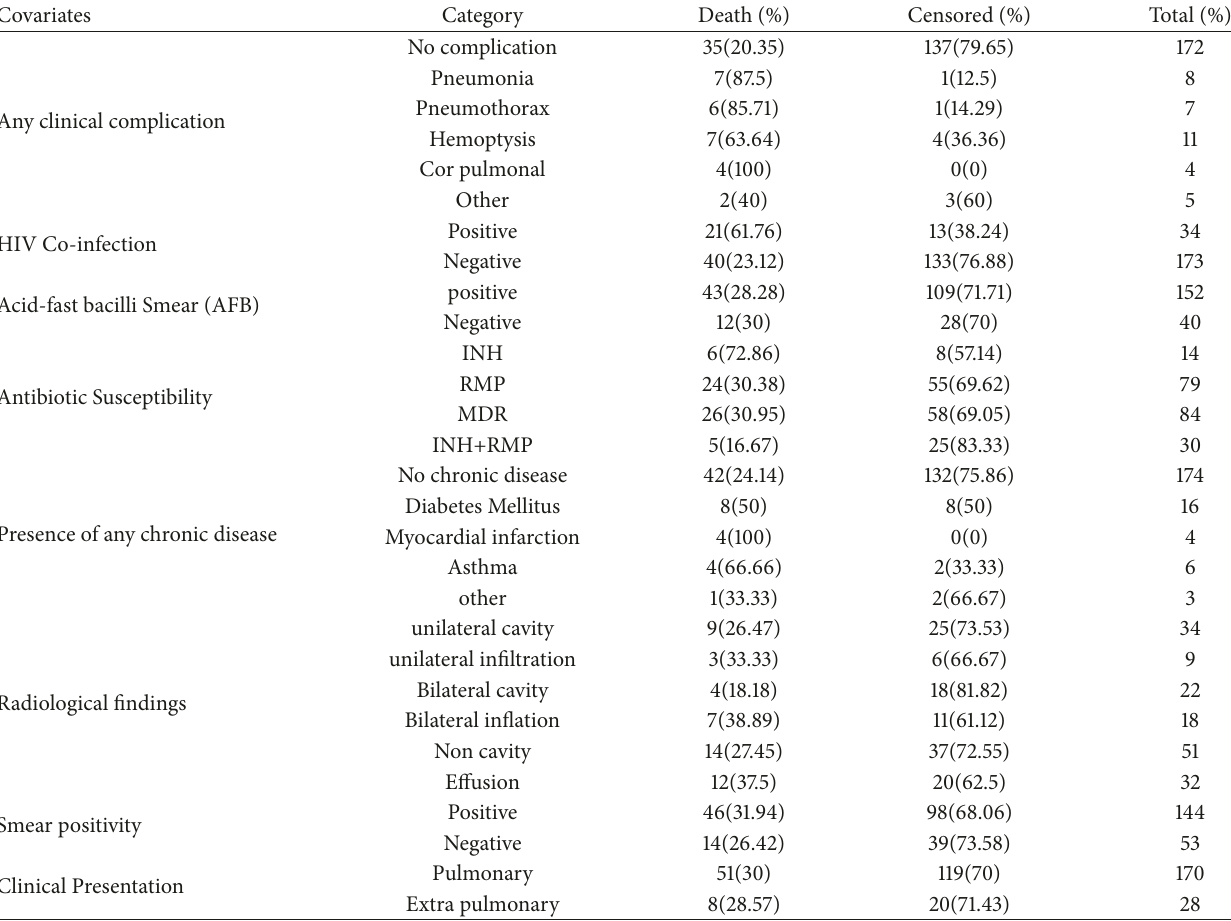
Table 2: Summary results of MDR–TB by clinical characteristics.